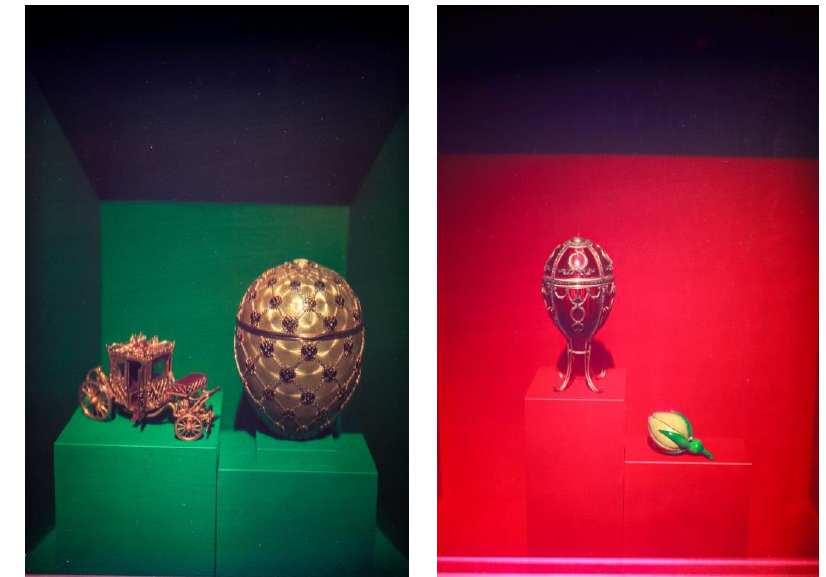
Figure 10 . Photos of the recorded OptoClones TM of the Coronation Imperial Easter Egg ( Left ) and the Rosebud Imperial Egg ( Right ) (© 2015 HiH)